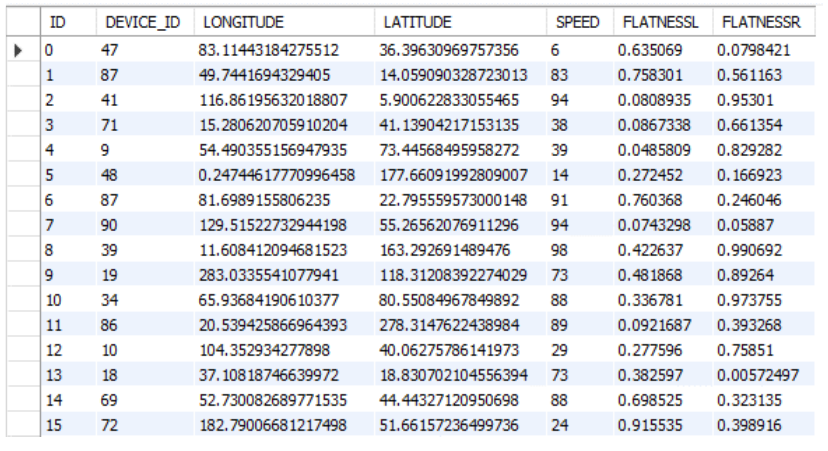
Figure 10. RDBMS Data sample.